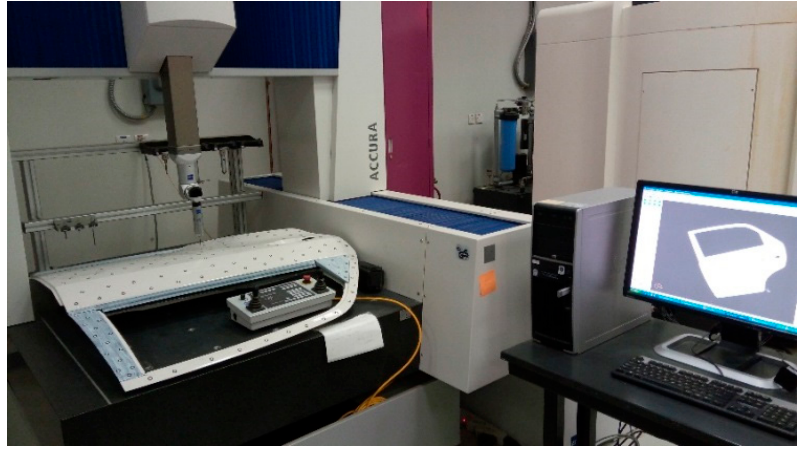
Figure 6. Bridge-type CMM. CMM: Coordinate Measuring Machine.